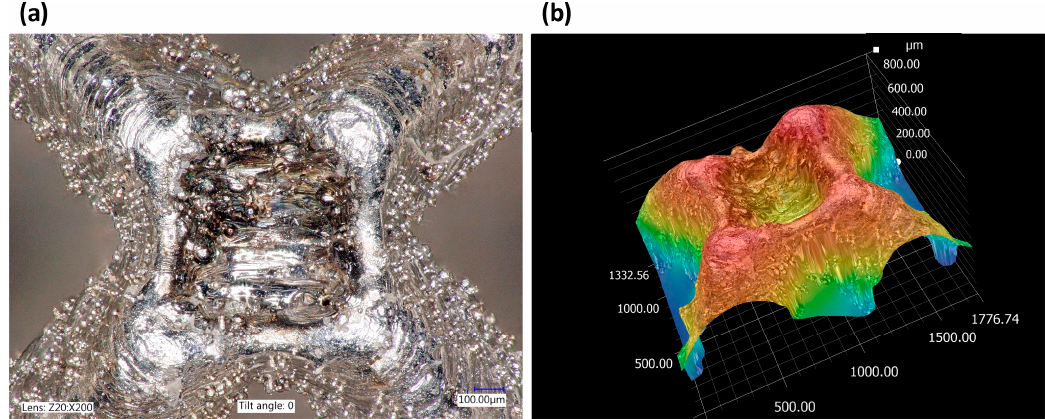
Figure 6. Optical micrographs showing the difference in height in connection places of struts: ( a ) general view of the connection place of struts, ( b ) differences in height in the connection place of struts.